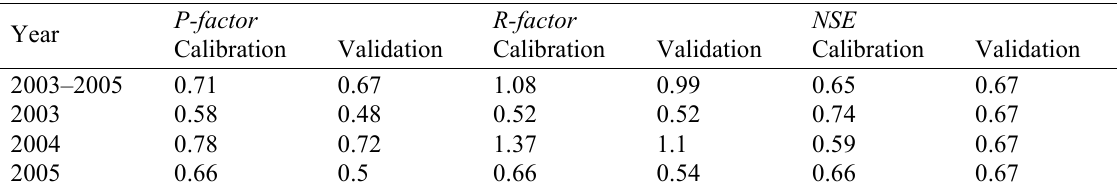
Table 2 Calibration and validation results for the four data sets.